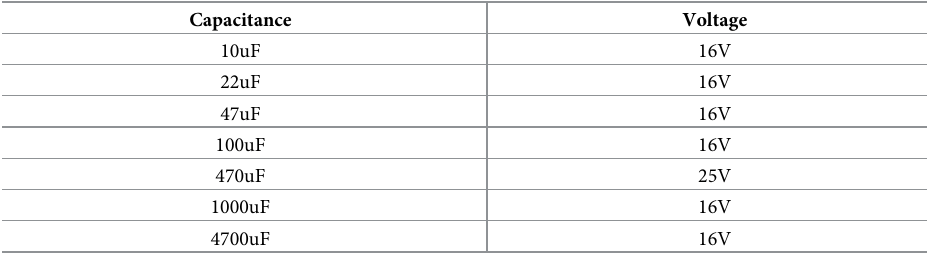
Table 1. Types of capacitors selected.